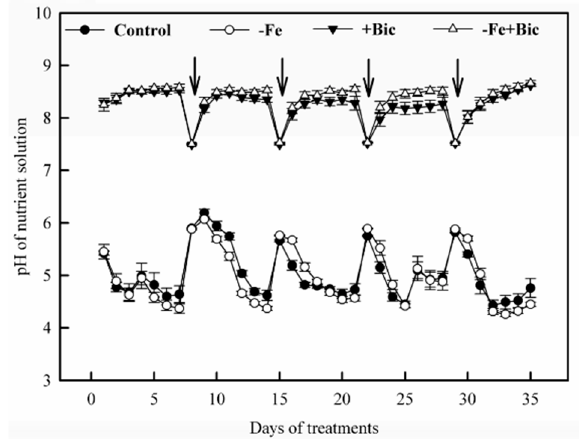
Figure 2. Changes in the pH of nutrient solution for -Fe, +Bic or -Fe+Bic conditions. Values are means of five replicates ± SE. The nutrient solution was renewed every 7 days during the experiment (arrow down).